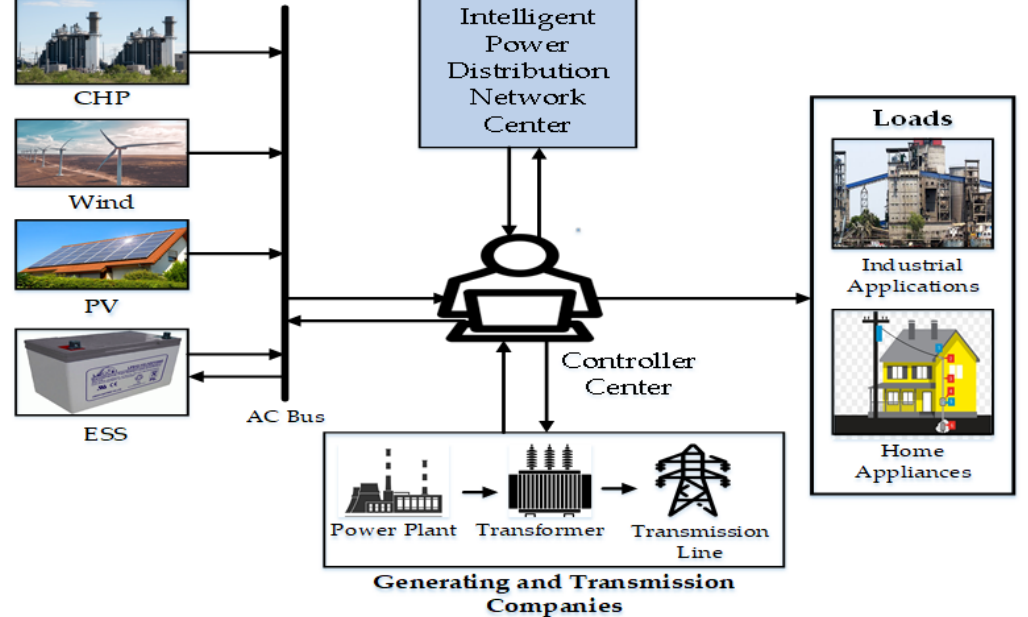
Figure 16. A bi-level stochastic scheduling optimization model for a virtual power plant (Redrawn with permission from [115], 2016, Elsevier).